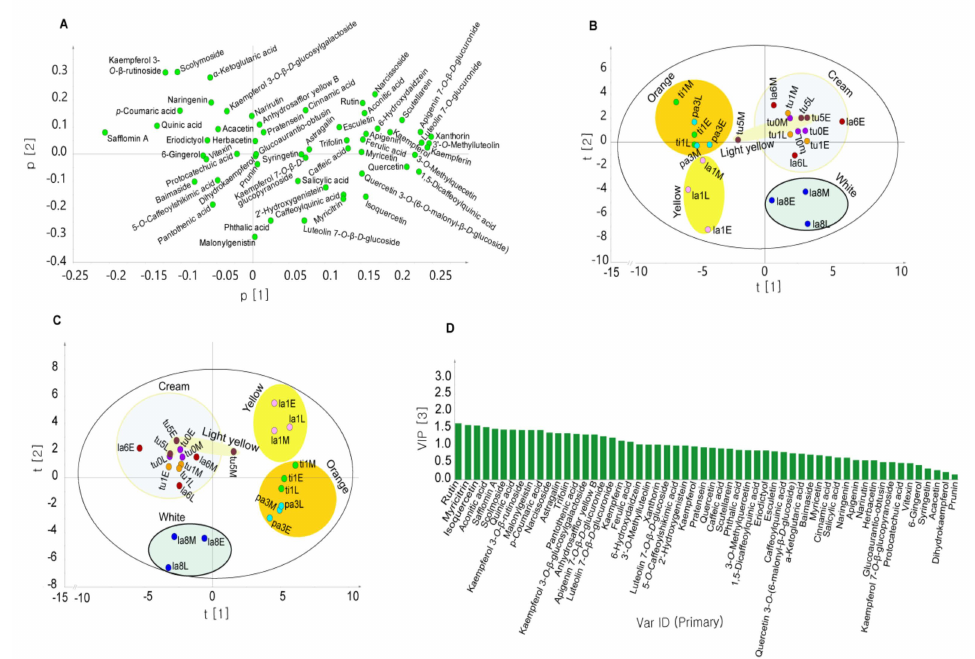
Figure 3. Loading ( A ) and score ( B ) plots of principal components 1 and 2 from the principal component analysis (PCA) and orthogonal partial least squares discriminant analysis (OPLS-DA) ( C ) and variable importance in projection (VIP) scores associated with metabolites ( D ) of wild and cultivated sa ffl